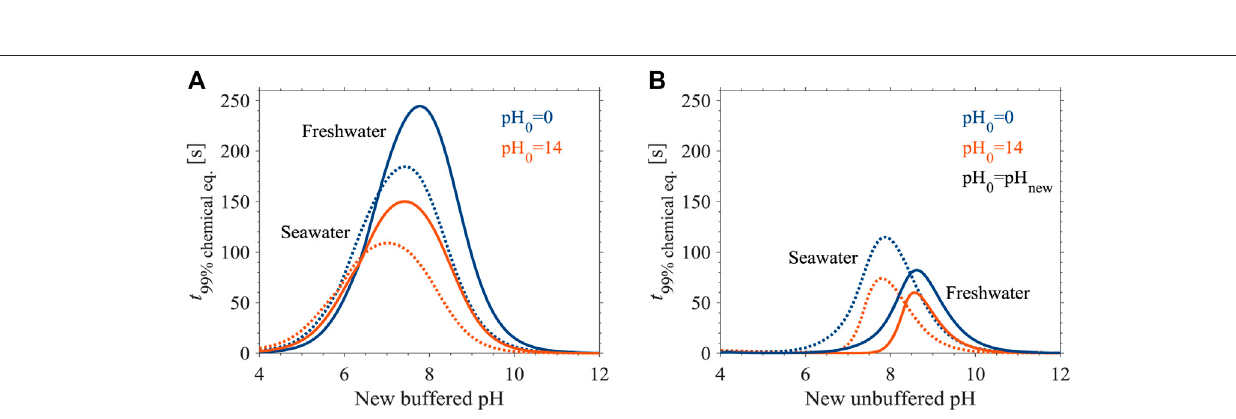
FIGURE 3 | Equilibration times during pH transitions at 25 ° C in 10 mM DIC seawater (dotted lines) and freshwater (solid lines) in (A) buffered and (B) unbuffered solutions. Perturbation theory equilibration times are shown in panel B for comparison (pH 0 (cid:1) pH new ; Eq. C.7.25 in Zeebe and Wolf-Gladrow, 2001).